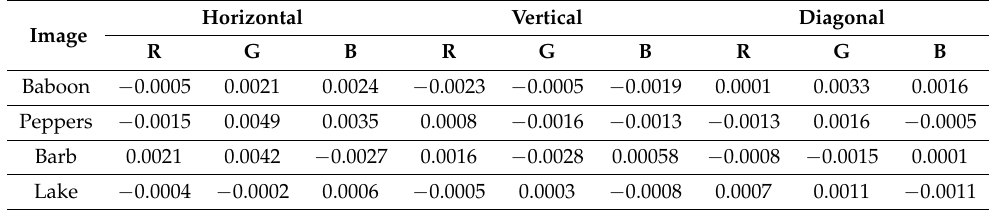
Table 2. Correlation coefficients of encrypted